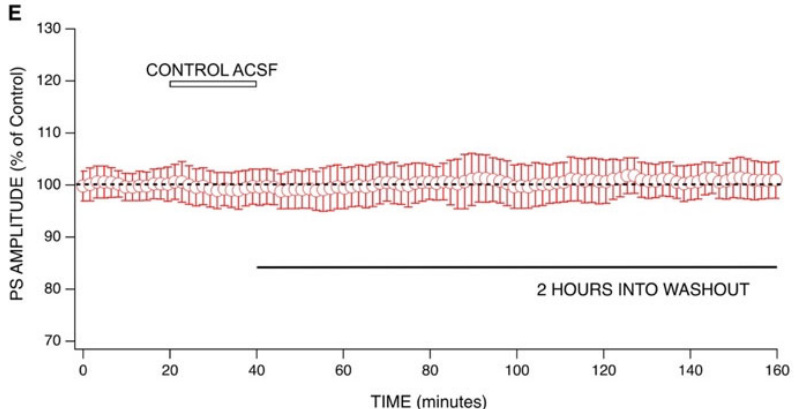
Figure 1. The effects of ketamine on population spike amplitudes. ( A ) Representative recordings from one ketamine experiment (10 µ M) showing changes in PS amplitudes during application and washout. ( B ) Combined graph of PS amplitudes vs. experimental time ( n = 7) shows 10 µ M ketamine produced a small depression in PS amplitudes during the first 10 min of perfusion. During the latter half of the application, ketamine appeared to have an increasing effect on PS amplitudes, which continued into washout. Amplitudes increased beyond baseline during washout and persisted for two hours. ( C ) Representative recordings from one ketamine experiment (350 µ M) showing changes in PS amplitudes during application and washout. ( D ) Combined graph ( n = 6) shows 350 µ M ketamine produced a depression in PS amplitudes during application. Conversely, an increase in PS amplitudes beyond baseline was seen during washout of ketamine which lasted for two hours. Comparing the two concentrations studied, there were no differences seen in the magnitudes of post-washout increases in excitability. ( E ) Combined graph ( n = 7) shows no change in population spike amplitudes when switching between two control ACSF solutions. Data points from each combined graph represent the mean ± standard deviation derived from a data set of several averaged experiments decimated from approximately 480 to 100 data